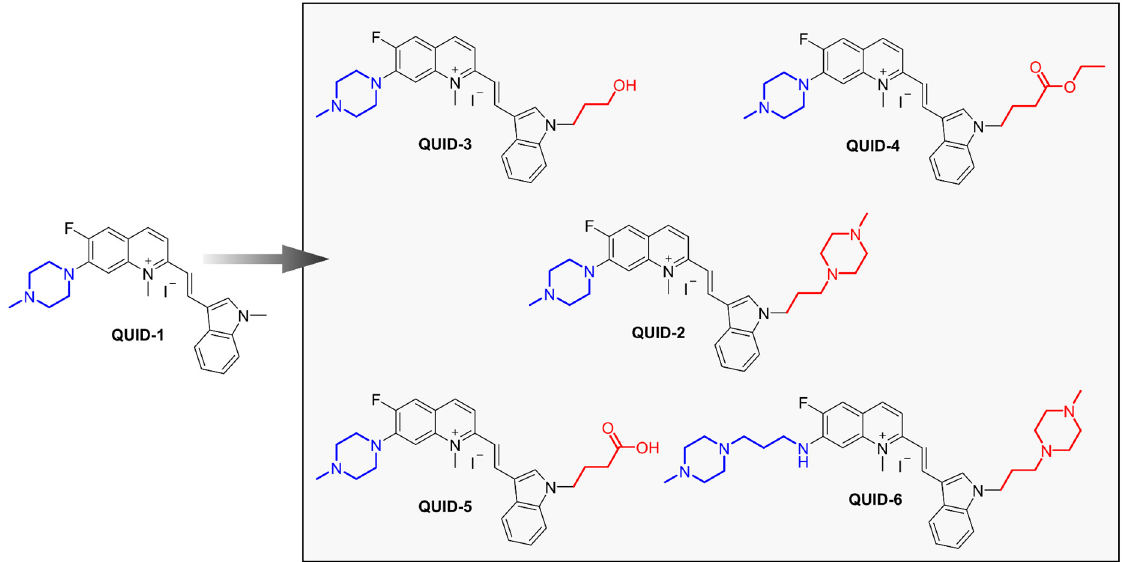
Figure 1. The structures of QUID − 1 and newly designed fluorescent probes QUID − 2 to QUID − 6